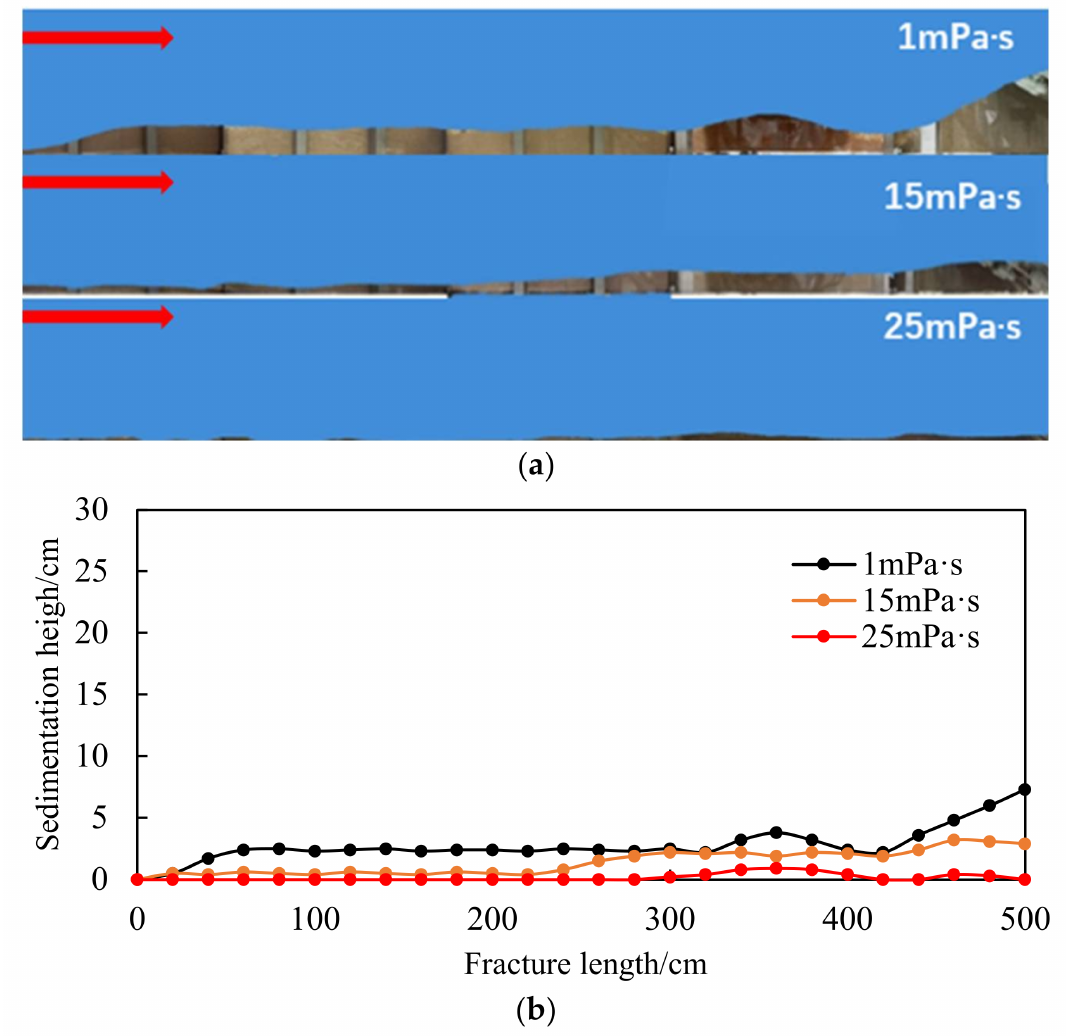
Figure 23. Experimental results and data results of migration of emulsion-phase resin phase change proppant in carrying fluids with different viscosities. ( a ) is the proppant migration experimental results; ( b ) is the data of experimental